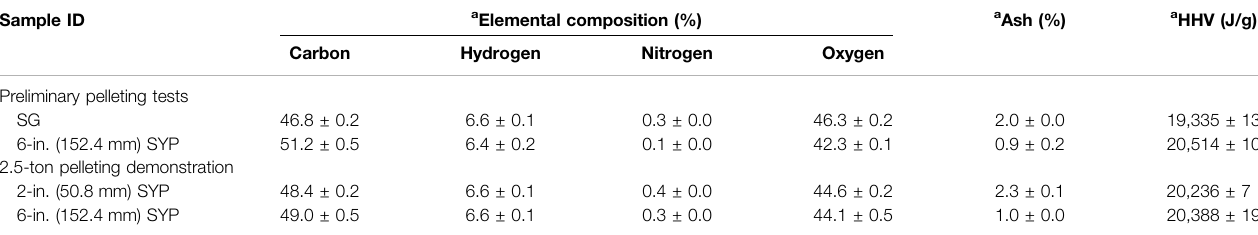
TABLE 2 | Ash, ultimate, and calorimetric analyses of the raw